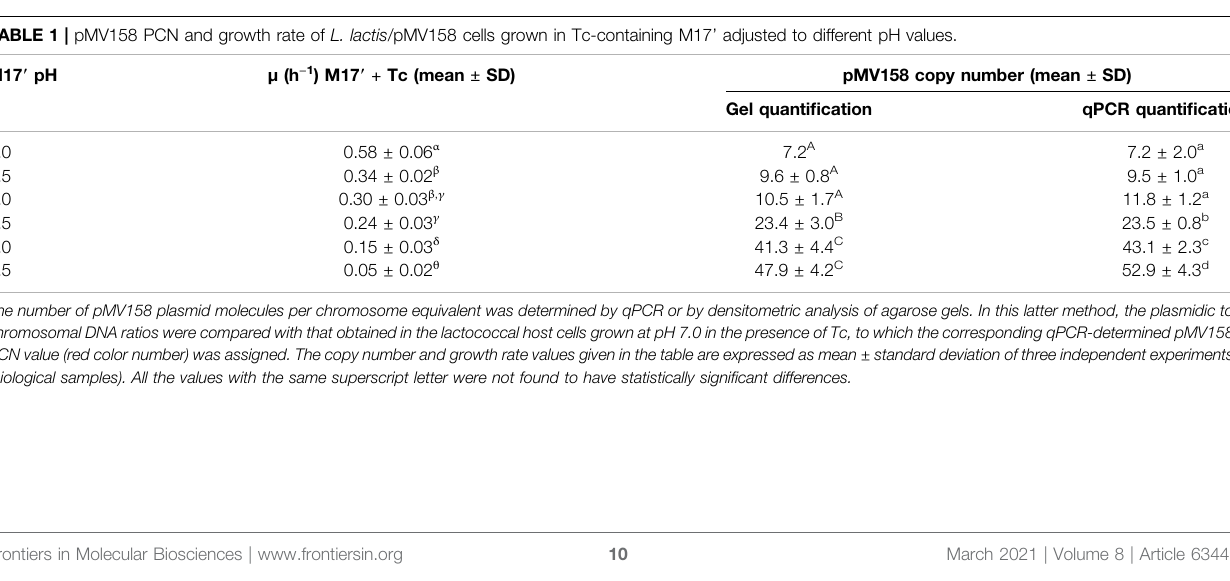
TABLE 1 | pMV158 PCN and growth rate of L. lactis /pMV158 cells grown in Tc-containing M17 ’ adjusted to different pH values.